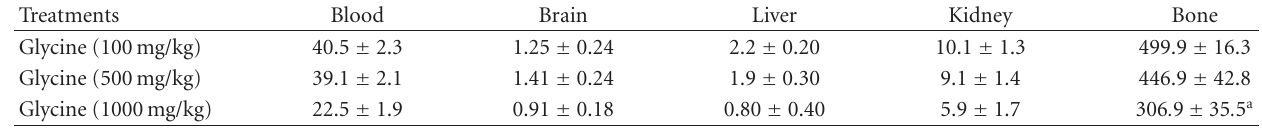
Table 2: Lead concentration in the blood ( μ g/dL), brain, liver, kidney, and bone ( μ g/g) of rats. Lead was given in drinking water for 5 weeks, after which, the lead was withdrawn, and glycine (100 or 500 mg/kg) treatment was given at a daily oral dose for 5 days, or glycine (1000mg/kg) treatment was given at a daily oral dose for 28 days. Treatments Blood Brain Liver Kidney Bone Glycine (100mg/kg) 40.5 ± 2.3 1.25 ± 0.24 Glycine (500mg/kg) 39.1 ± 2.1 Glycine (1000mg/kg) 22.5 ± 1.9 a P < 0 . 05 compared with its positive lead